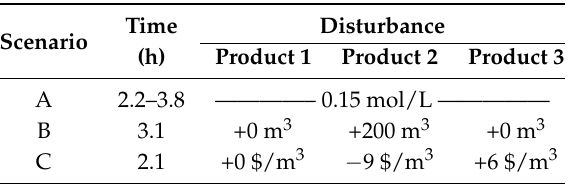
Table 6. Scenario